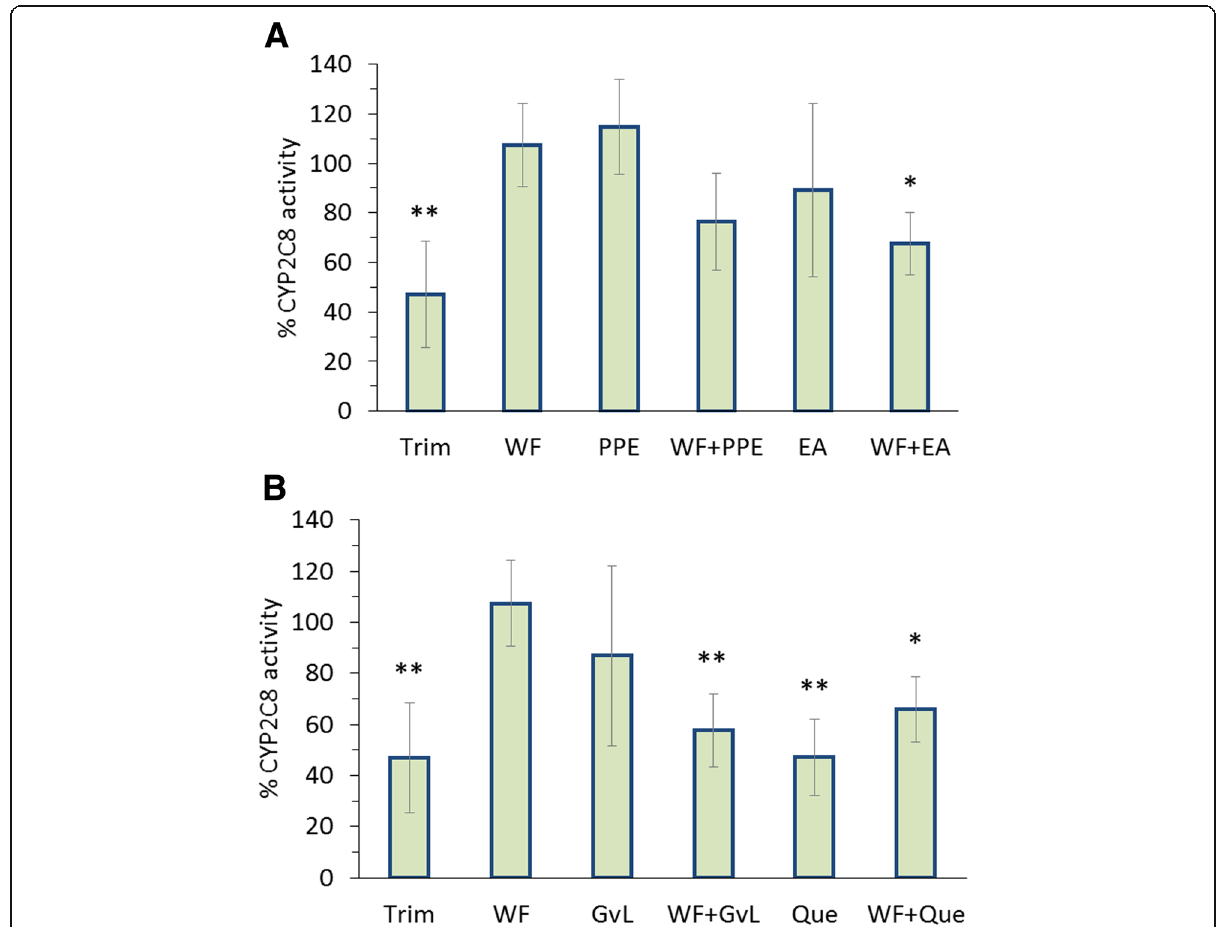
Fig. 4 Percentage of CYP2C8 activity relative to untreated isolated hepatocytes of different groups treated with trimethoprim (30 μ g/ml), and warfarin (3 μ g/ml) alone or in combination with: ( a ) pomegranate peel extract (120 μ g/ml), ellagic acid (48 μ g/ml) or, ( b ) guava leaves extract (294.1 μ g/ml) and quercetin (15 μ g/ml). Each data point represents the mean ± SD ( n = 6). Statistical evaluation was performed by comparing the percentage of activity of untreated cells with treated cells *p < 0.05, **p <